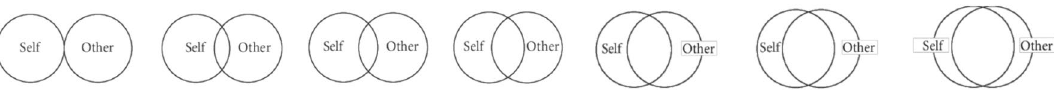
Figure 1. The Inclusion of Other in the Self Scale, which offers a continuum for expressing the sense of unitive